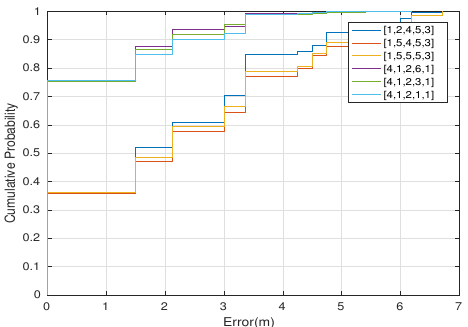
Figure 14. Positioning error for SVM (with a quadratic polynomial kernel function). In both plots, the three best and the three worst combined transmission power for each BLE4.0 beacon are shown.